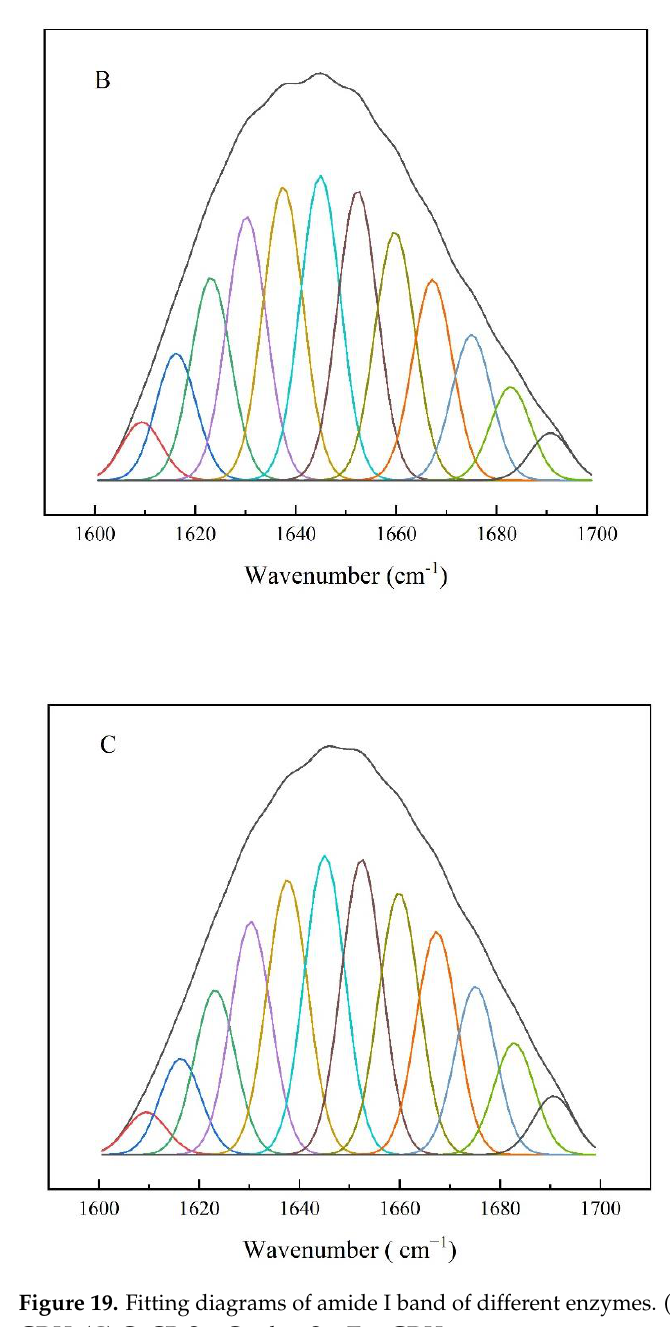
Figure 19. Fitting diagrams of amide Ⅰ band of different enzymes. ( A ) SpyCatcher-CpCR. ( B ) SpyTag-GDH. ( C ) CpCR-SpyCatcher-SpyTag-GDH.